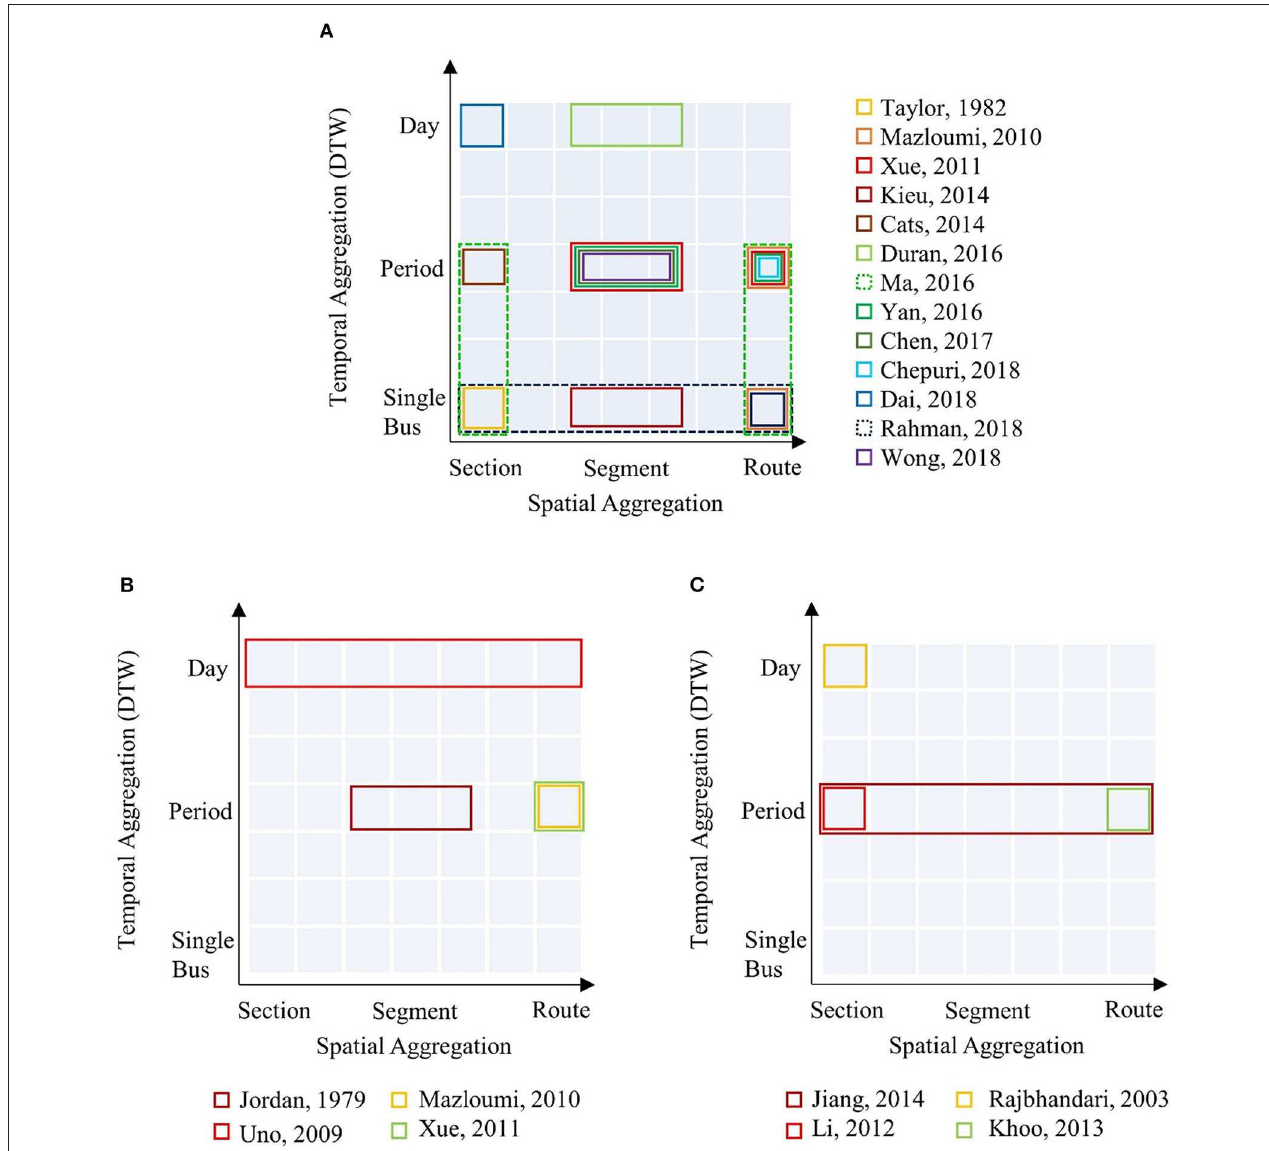
FIGURE 4 | Representations of spatial and temporal aggregation of (A) travel time, (B) running time, and (C) dwell